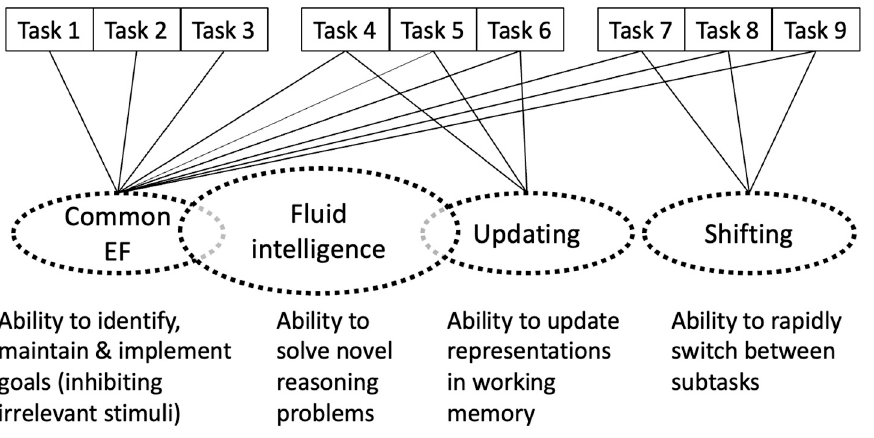
Figure 1. What is the relationship between fluid intelligence and cognitive abilities? We conceptu- alise them as emerging properties of dynamic interactions between multiple internal and external constraints. The system (individual) adapts to the external world (represented here by cognitive tasks (the nine boxes)) by actively selecting and implementing goals. This appears to involve the coordination of a core set of structures and functions ( common executive function or common EF ). How- ever, to succeed on some tasks, the individual must also replace (update) a goal with another and/or rapidly shift between goals. Fluid intelligence is the ability to reason or implement a goal (independ- ent of acquired knowledge) and update the working memory. It therefore overlaps with common EF and updating.